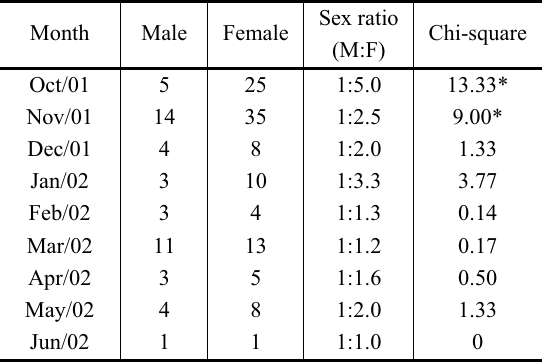
Number of males and females M. equidens collected each month (no males were collected from July onwards) and values of Chi-square for the deviation of the sex ratio from 1:1 (1 degree of